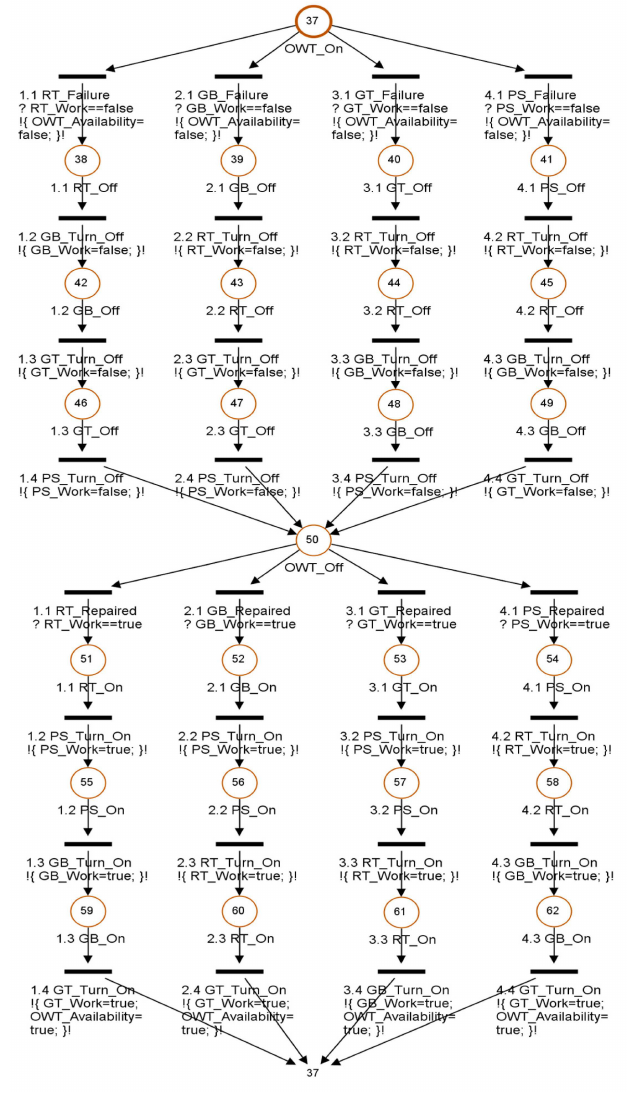
Figure 3. Total system